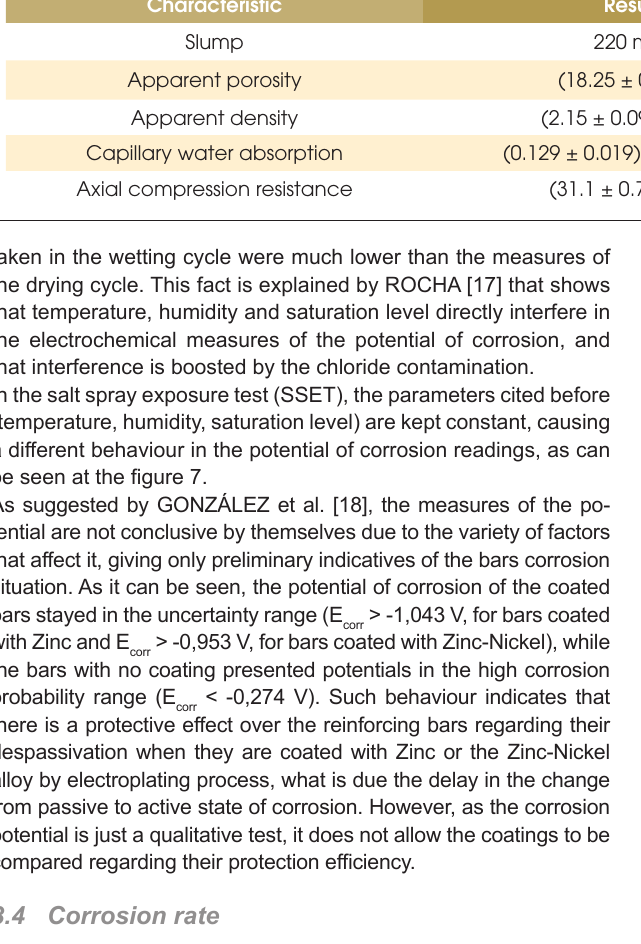
Proportion (cement : dust : crushed stone :